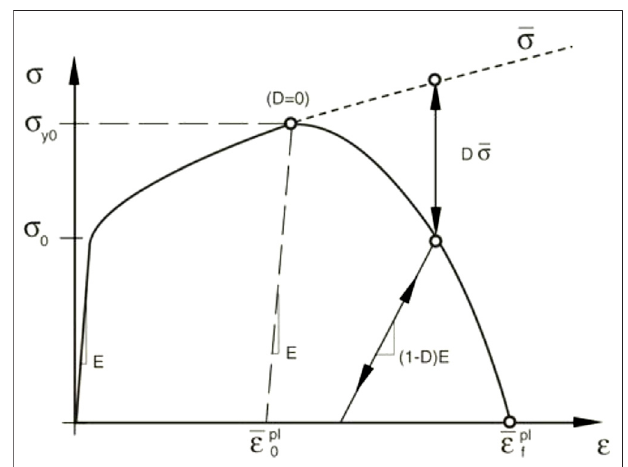
FIGURE 1 | Stress-strain curve with progressive damage